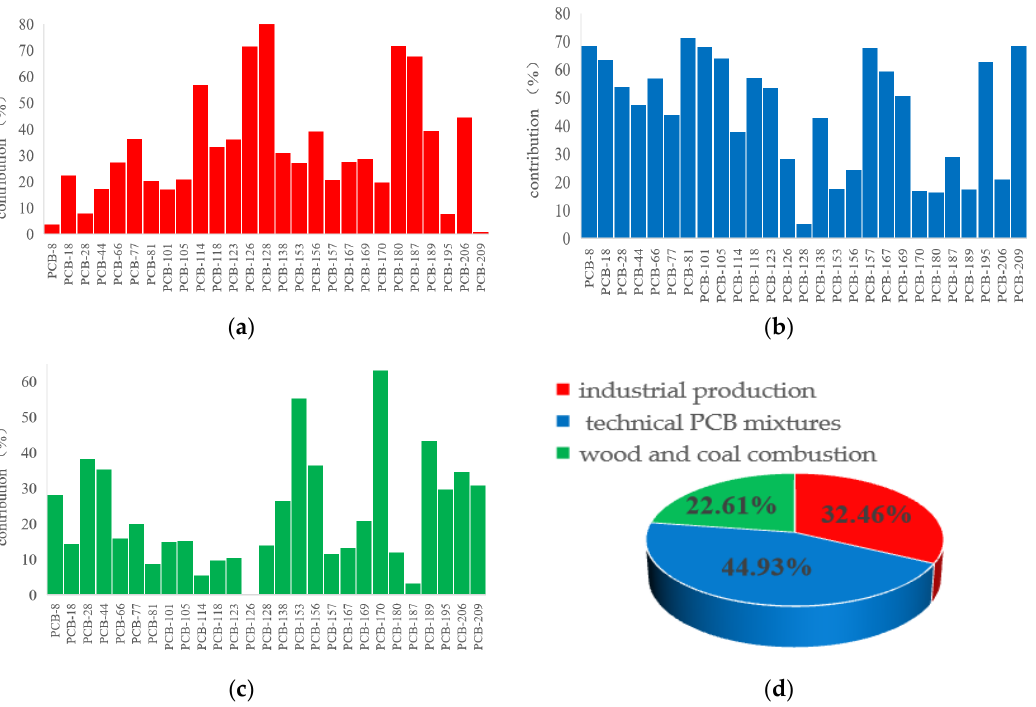
Figure 3. Positive matrix factorisation source profiles of PCBs ( a – c ). The bars represent the contribution of each factor to the corresponding PCB. ( d ) The pie chart shows the contribution of each factor to the total PCBs.